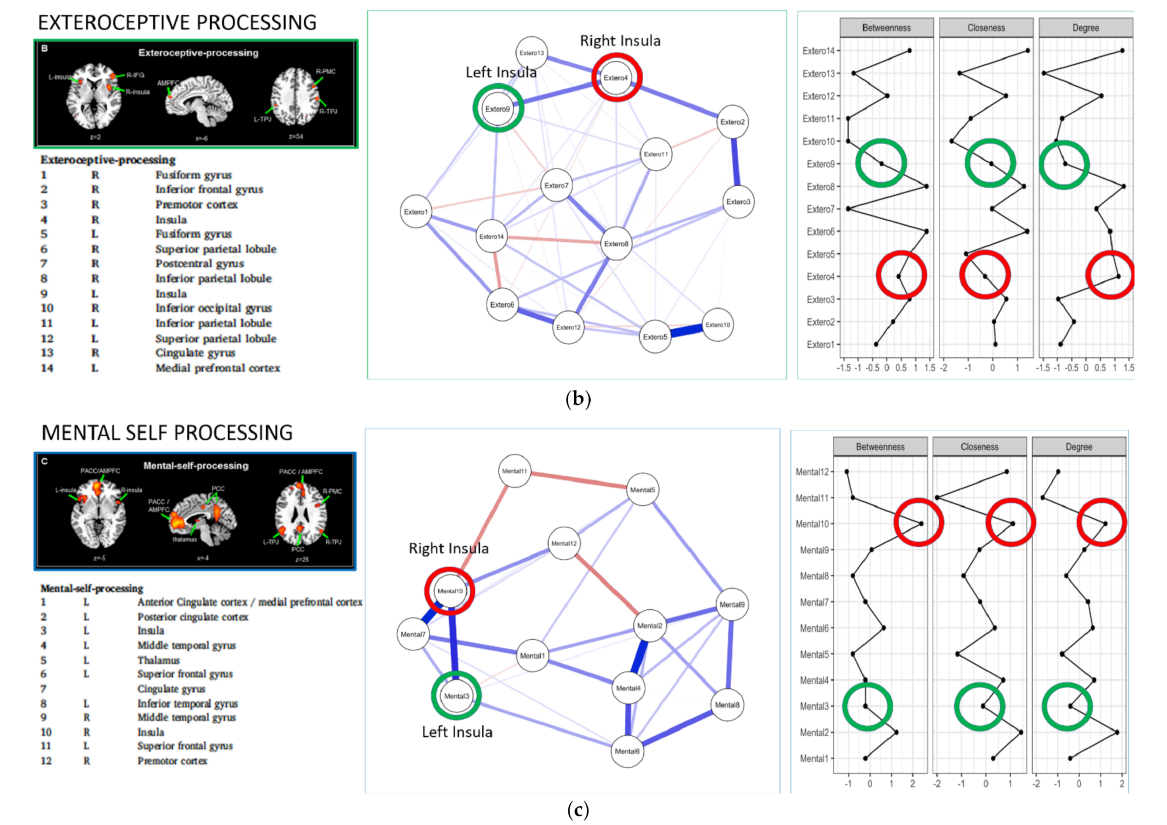
Figure 1. Resting state network analyses of the Three Layers Model of Self. ( a ) Interoceptive processing level; ( b ) exterocep- tive processing; ( c ) mental self-processing. Blu lines indicate positive relation between nodes. Red lines indicate negative relation between nodes. The thickness of the lines indicates the degree of relation between